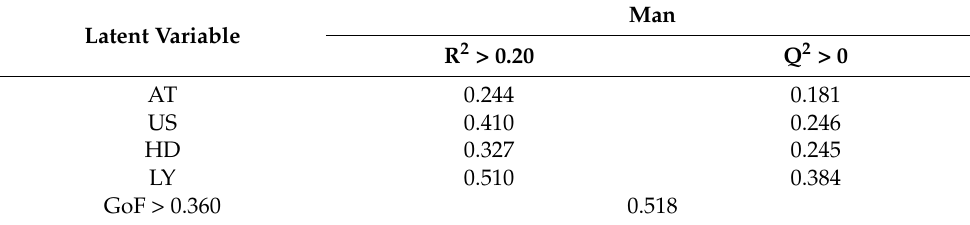
Table 7. MICOM. Man Latent Variable R 2 > 0.20 Q 2 > 0 AT 0.244 0.181 US 0.410 0.246 HD 0.327 0.245 LY 0.510 0.384 GoF > 0.360